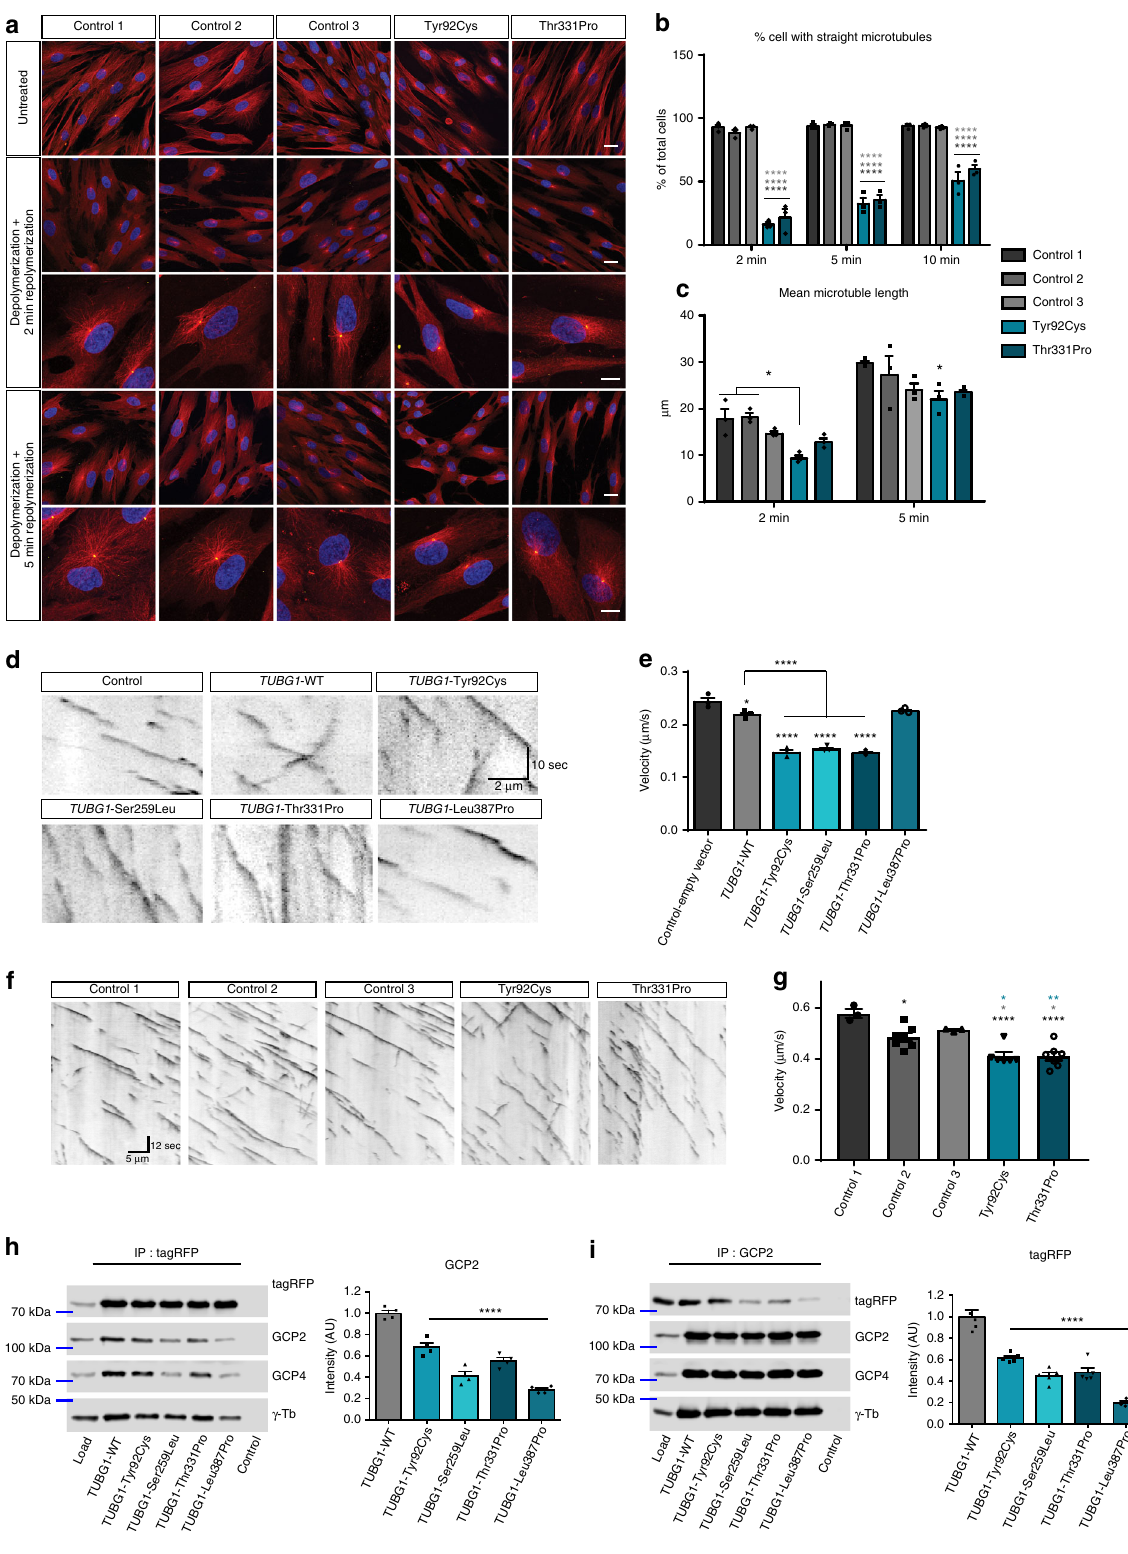
Tubg1 Y92C/ + mice show behavioral and epileptic anomalies . Given the neuroanatomical abnormalities observed in the Tub- g1 Y92C/ + mice, and the fact that cognitive function is impaired in subjects with MCDs, we tested whether this correlates with behavioral abnormalities by performing a battery of tests